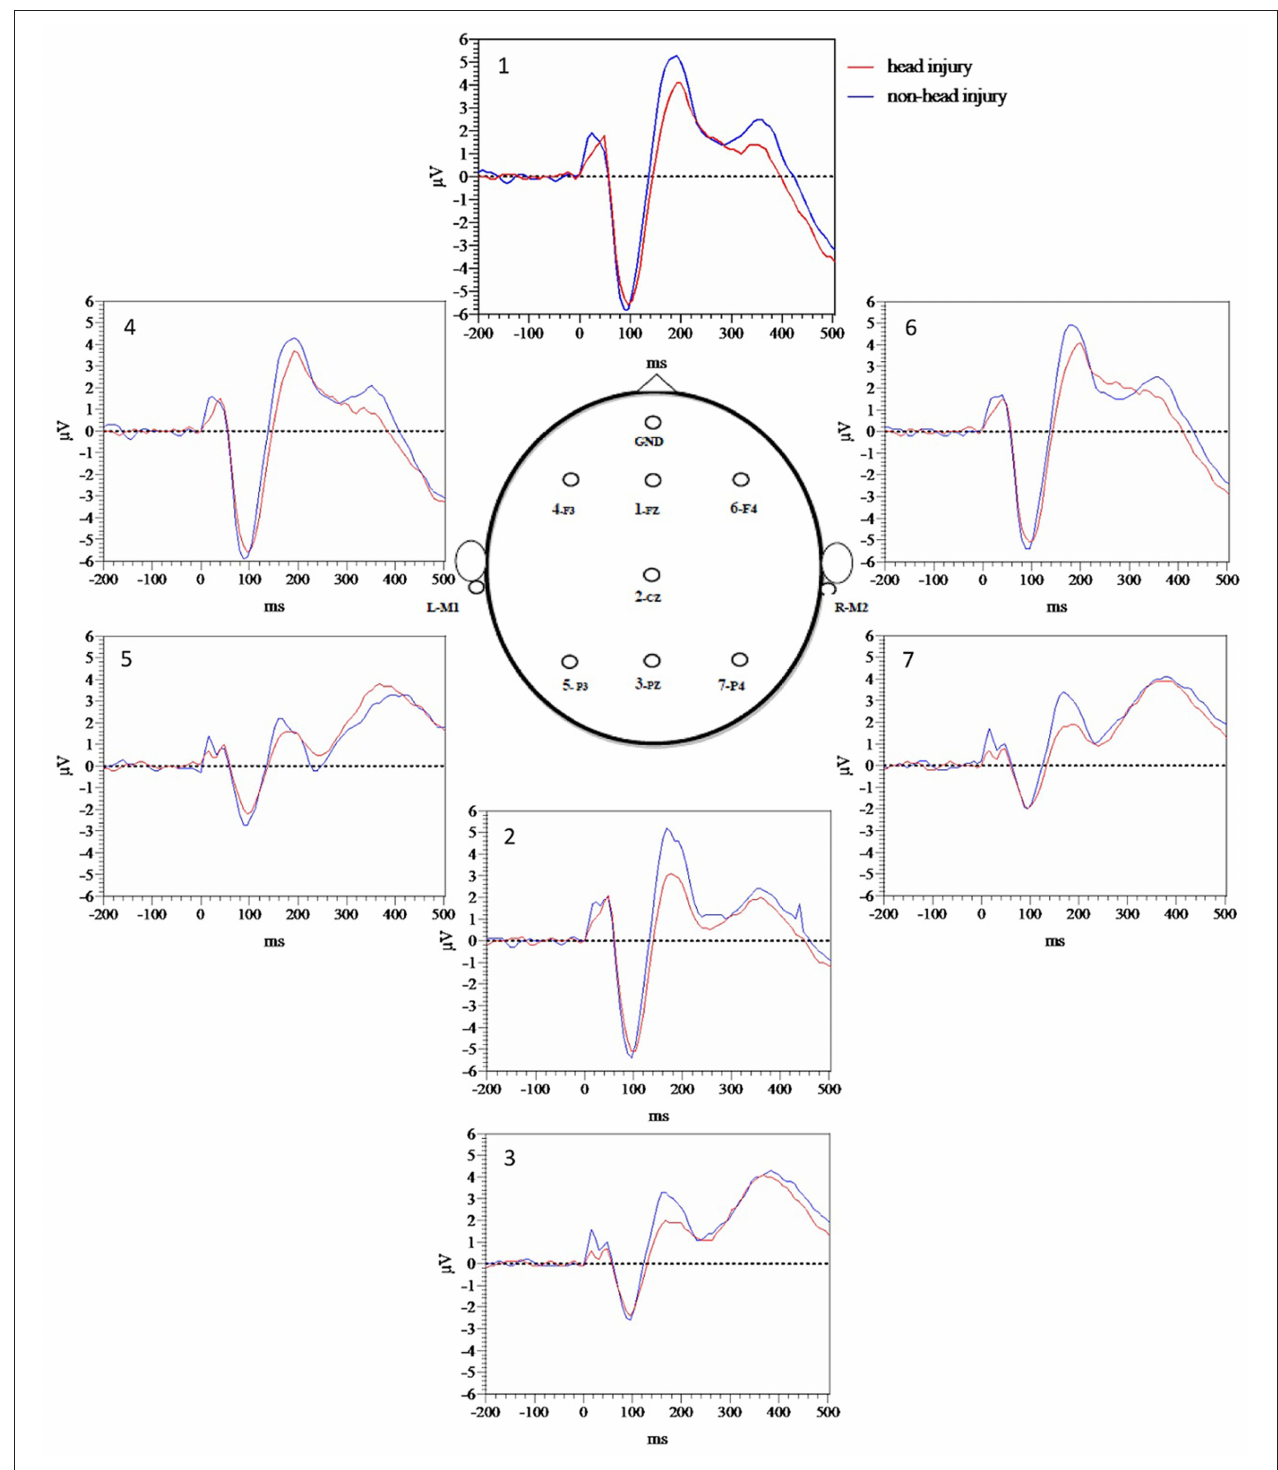
FIGURE 1 | Target tone grand average waveforms for each